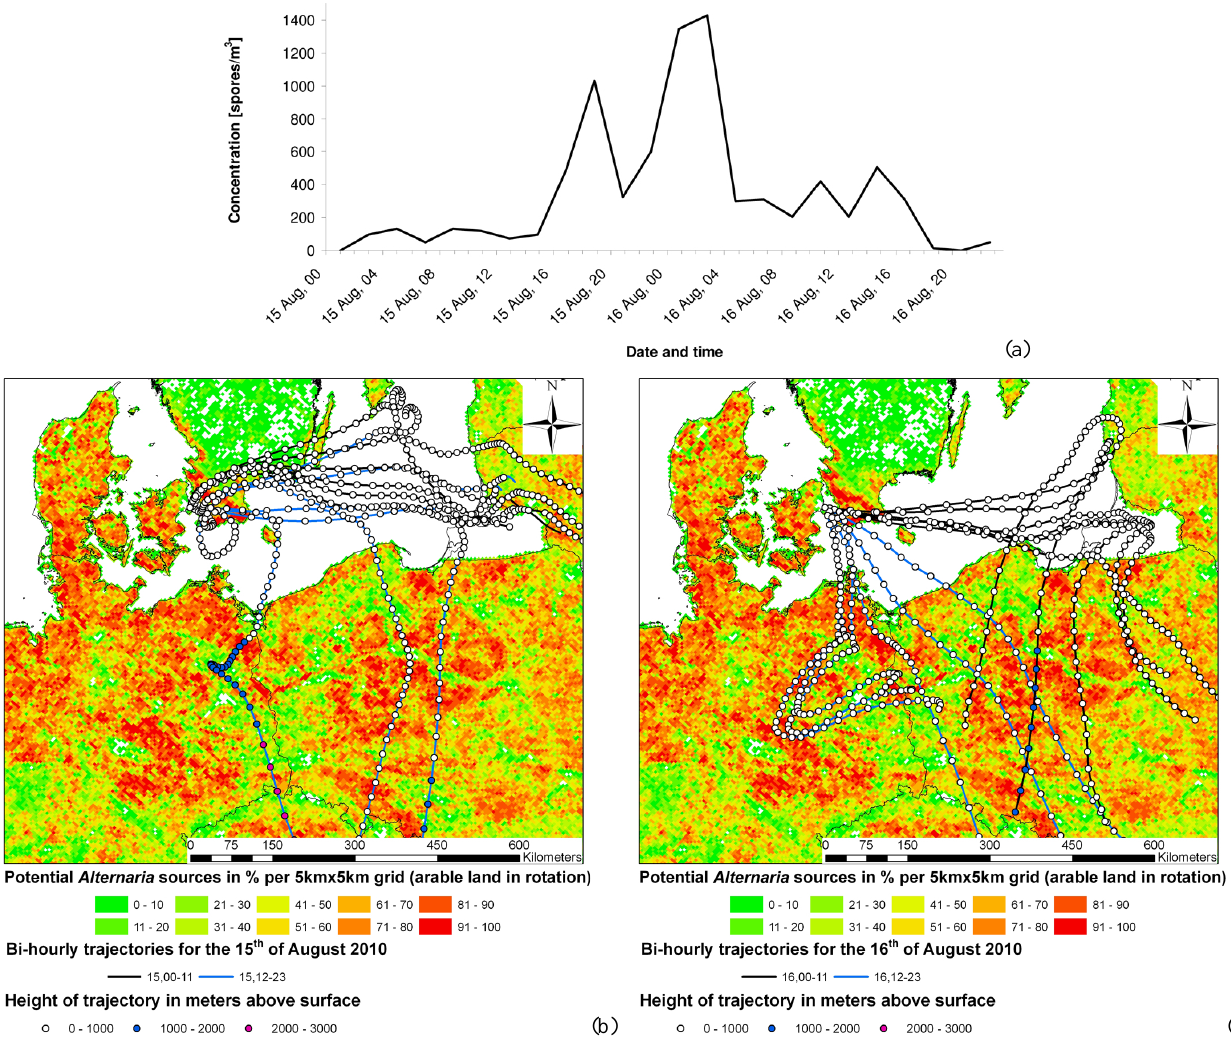
Fig. 5. (a) Bi-hourly variation in Alternaria spore concentrations (sporesm − 3 ) obtained in Copenhagen 15 and 16 August 2010. Back- trajectories arriving at the spore trap in Copenhagen: (b) 15 August; (c) 16 August. The distance between two dots on a trajectory corresponds to one hour of atmospheric